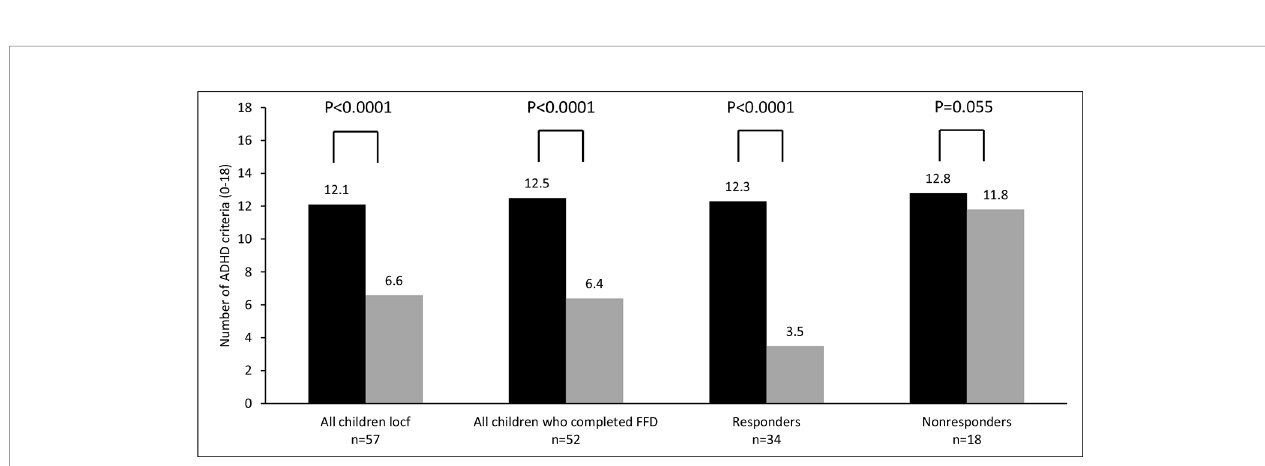
FIGURE 2 | Distribution (Box-Whisker plots) of teacher measurements in percentages of maximum scores at start and end of the 5-week few-foods diet (FFD) in children with (dark grey) and without (light grey) medication at start. Dark grey boxes: 8/18 children taking medication at start (1/8 still taking medication at end). Light grey boxes: 10/18 children not taking medication, neither at start nor at end. To facilitate comparison between the 2 measures, scores have been standardized as percentages of the maximum score per measure. ACS, Abbreviated Conners ’ Scale, maximum score 30 (100%). ARS, ADHD Rating Scale. ARSall, total score, maximum score 54 (100%). ARShyp, hyperactivity/impulsivity score, maximum score 27 (100%). ARSinatt, inattention score, maximum score 27 (100%). Shaded boxes denote interquartile range; Horizontal bars within boxes denote median; Whiskers denote 1.5 times the interquartile range, rolled back to an actual data point; Dots are outside